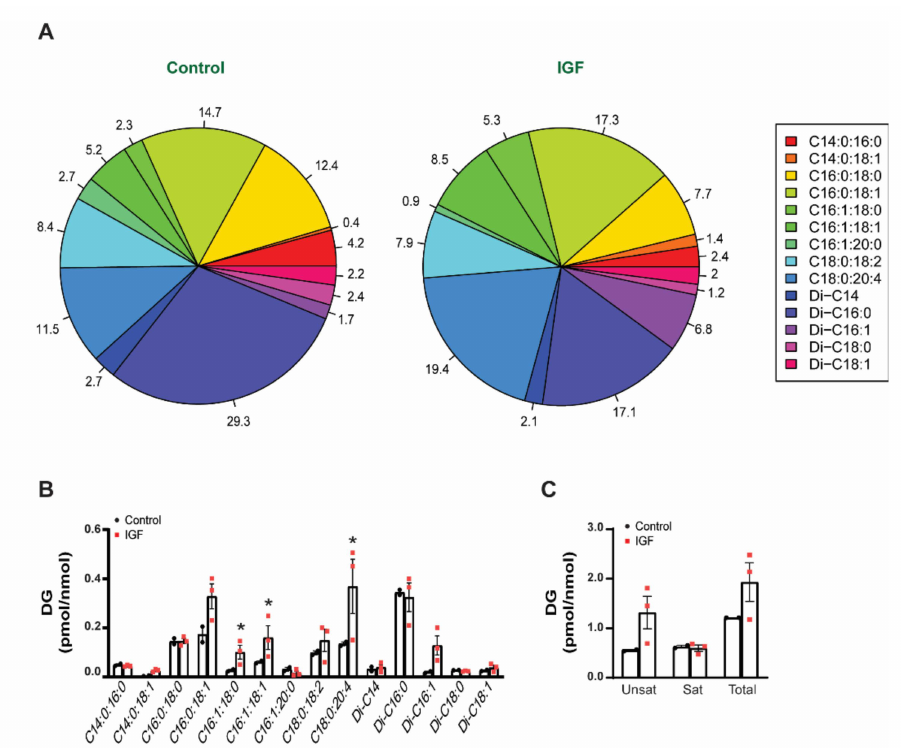
Figure 4. Effect of IGF-1 treatment on the diacylglycerol (DG) composition of myotube-derived EVs: ( A )—pie chart highlighting the DG species in myotube-derived EV control and IGF-treated myotube-derived EVs; ( B )—DG species normalized for the amount of lipid-associated phosphate (a measure of total phospholipids in each preparation); ( C )—unsaturated, saturated, and total DG in control and IGF EVs. Data are presented in percentage ( A ) and as the mean ± SE ( B , C ) ( n = 3), with significance denoted by an asterisk compared to the